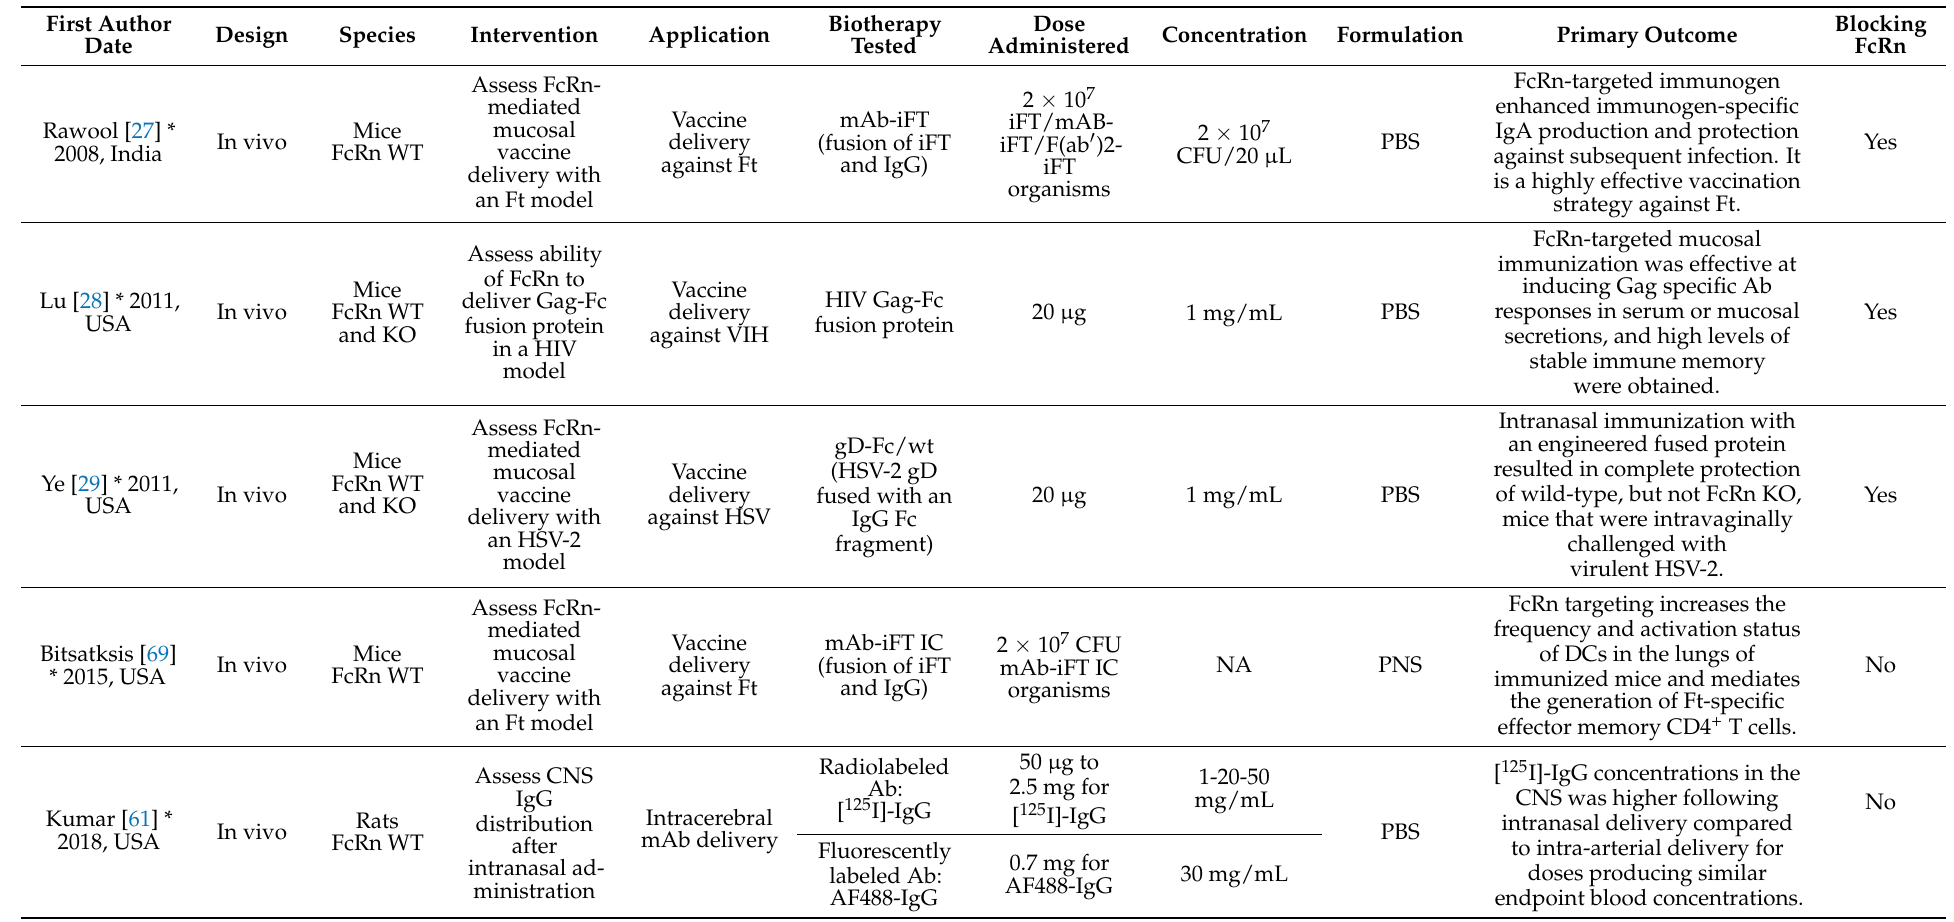
Table 1. Characteristics of the included